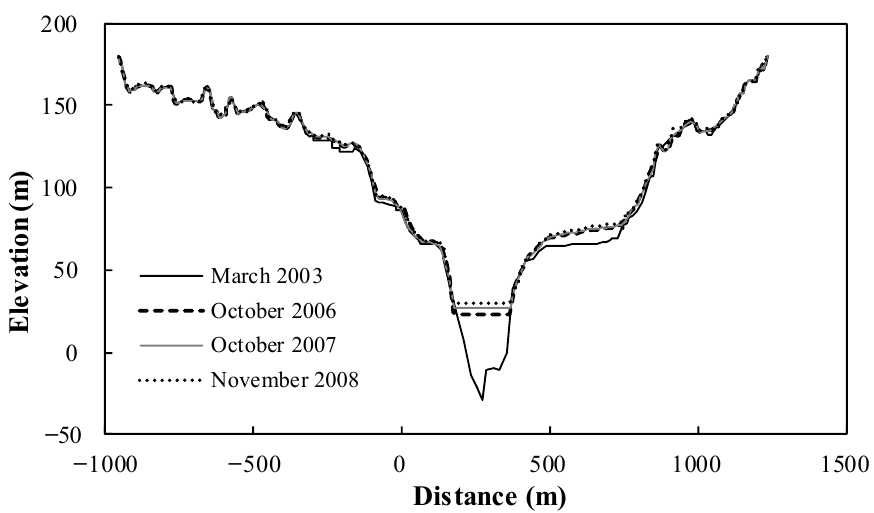
Figure 3. Observed sedimentation pattern on a typical cross ‐ section (Section S34#) near the TGD.